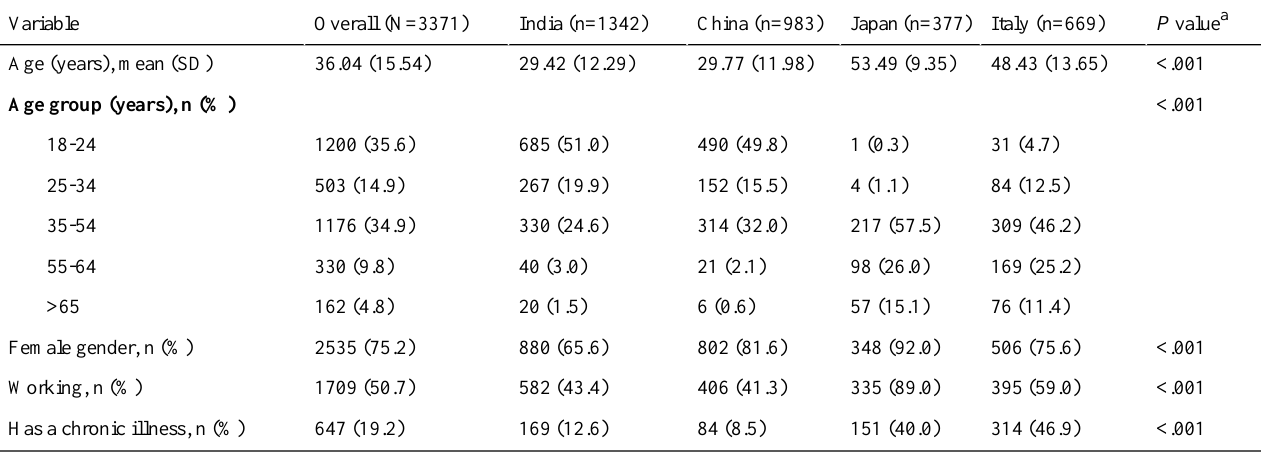
Table 1. Countrywise representation of the personal characteristics of the survey